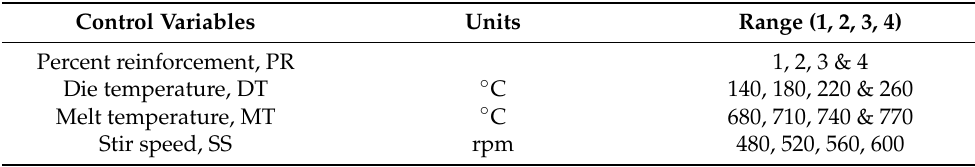
Table 1. Input factors and levels of stir casting